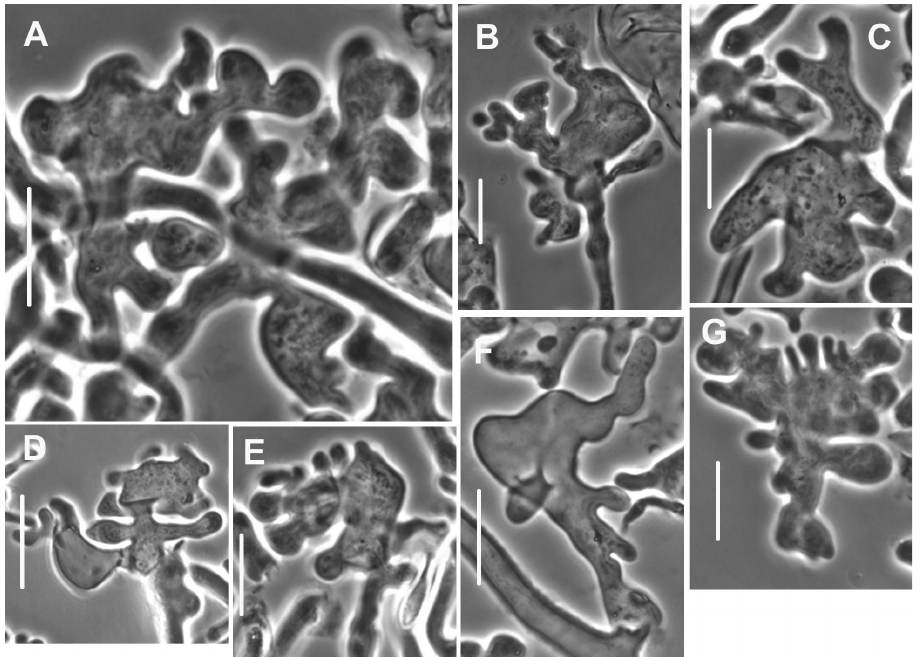
Figure 22. Mycetinis copelandii Pileipellis elements. Free-form, lobose individuals. Standard bars = 10 µm. TFB 8084